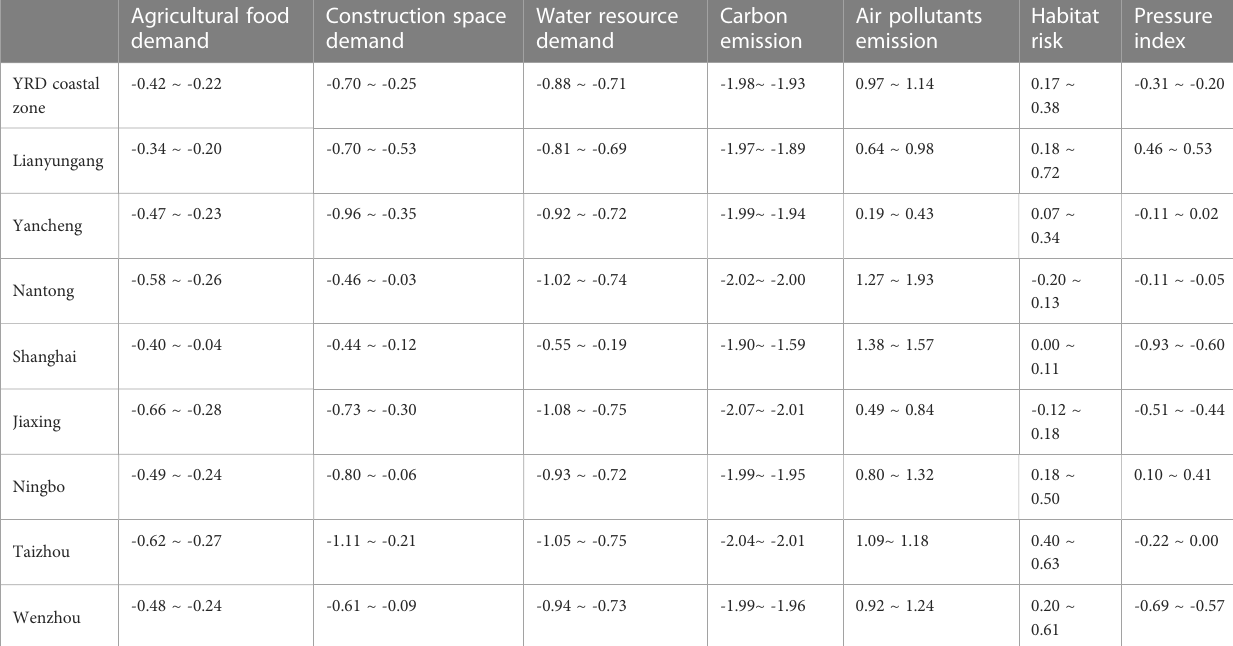
TABLE 5 Pressure index change in 2020-2050